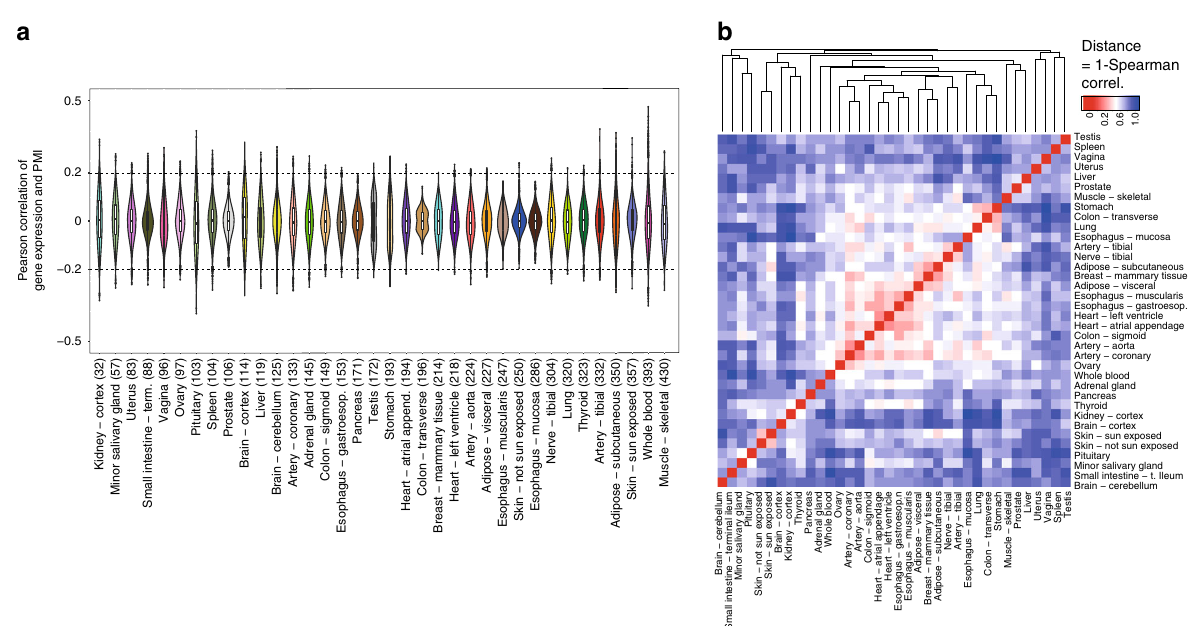
Fig. 3 PMI and gene expression correlation patterns. a Distribution of Pearson correlation between gene expression and PMI, across the different tissues (sorted by sample size, in parenthesis). Only for a few genes, this correlation exceeds an absolute r -value of 0.2. b Clustering based on the ranking (Spearman) correlation of the values in ( a ) show that sub-tissues of a given tissue or closely related organs have the similar patterns of